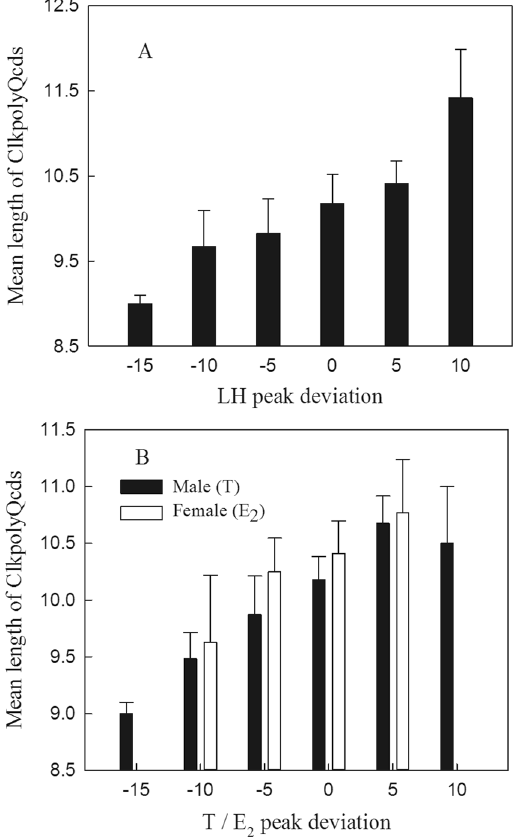
Figure 4. The mean lengths of Clock poly-Q allele length of the birds with different LH, T and E2 peak date deviation.